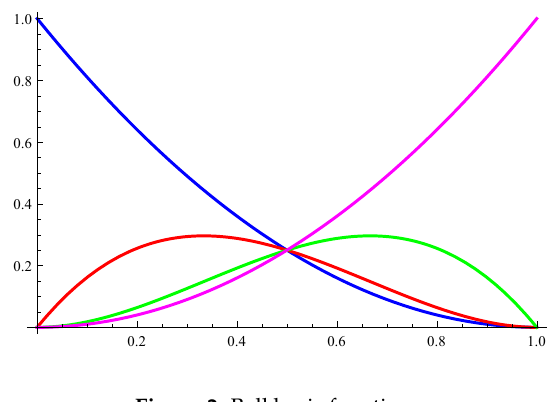
Figure 2. Ball basis